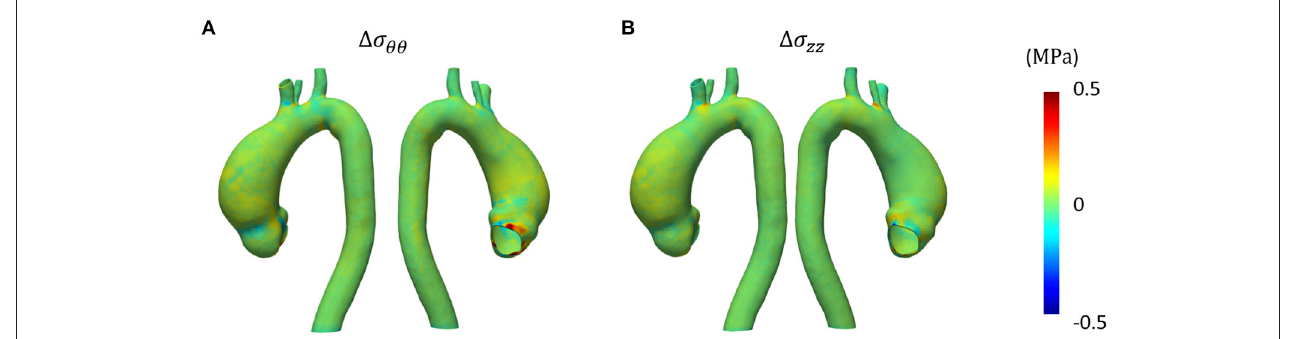
and the non-linear FSI, in terms of σ θθ and σ zz . The point- wise comparison of the stress maps, reported in Figure 10 , confirms the trends of Figures 8 , 9 . The only non-negligible errors are confined around the constrained boundaries.